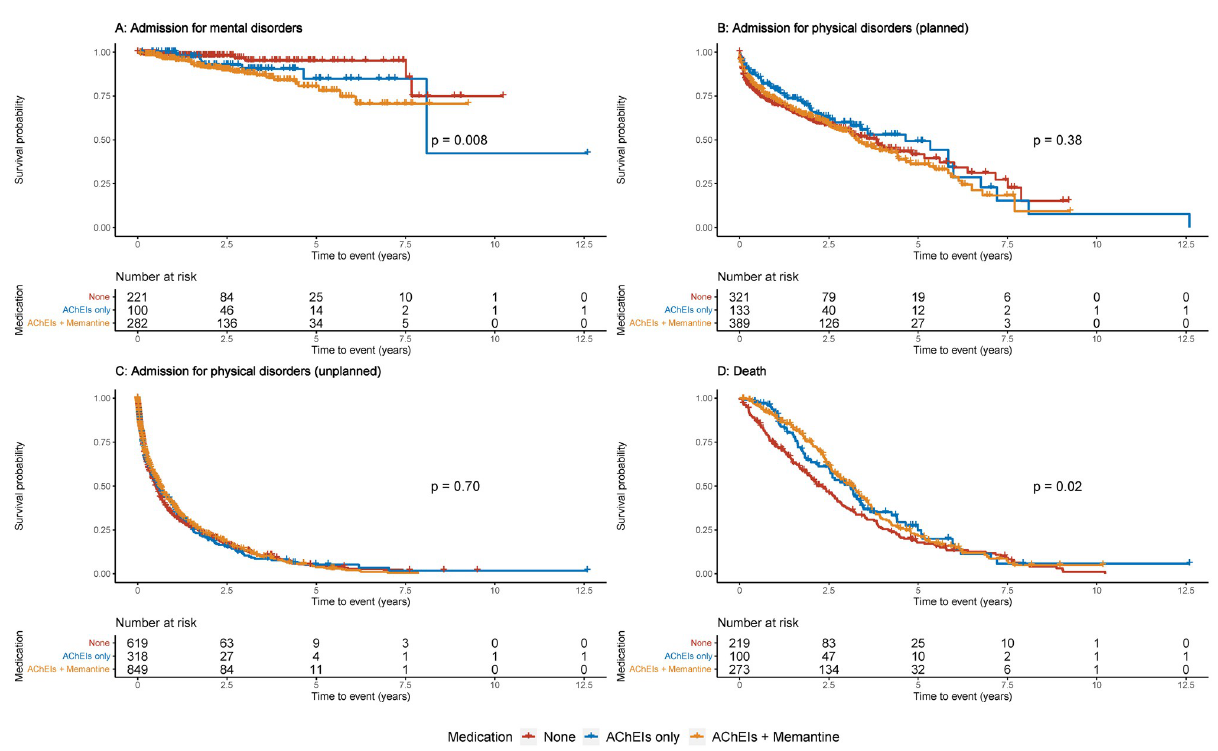
Fig 2. Kaplan-Meier survival curves of admissions and mortality in patients with dementia with Lewy bodies, by medication use. Panels A, B and C present the recurrent events. P values are calculated from the log-rank test. AChEIs, acetylcholinesterase inhibitors.